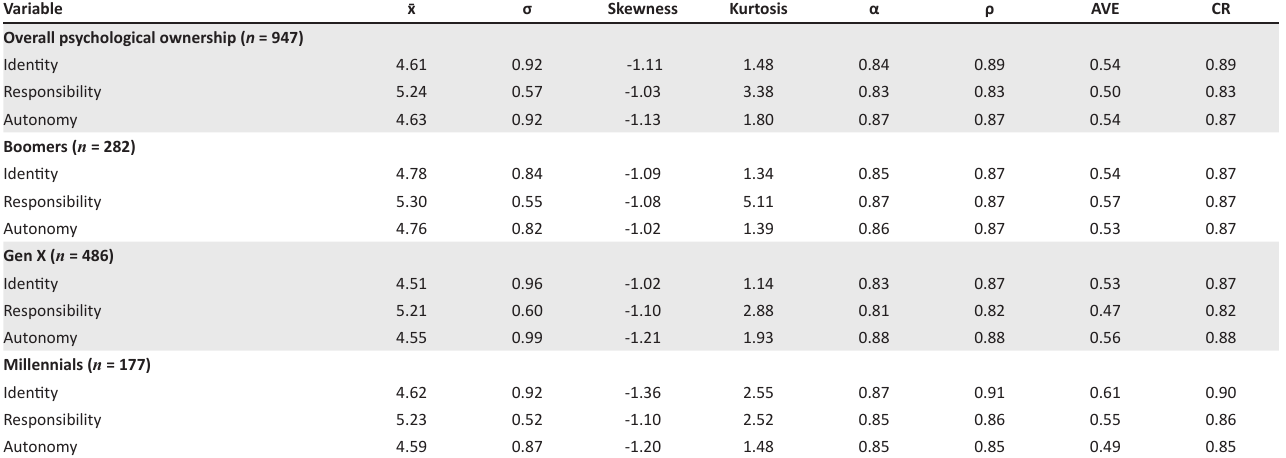
TABLE 2: Descriptive statistics, reliabilities, average variance extracted values across generations. Variable